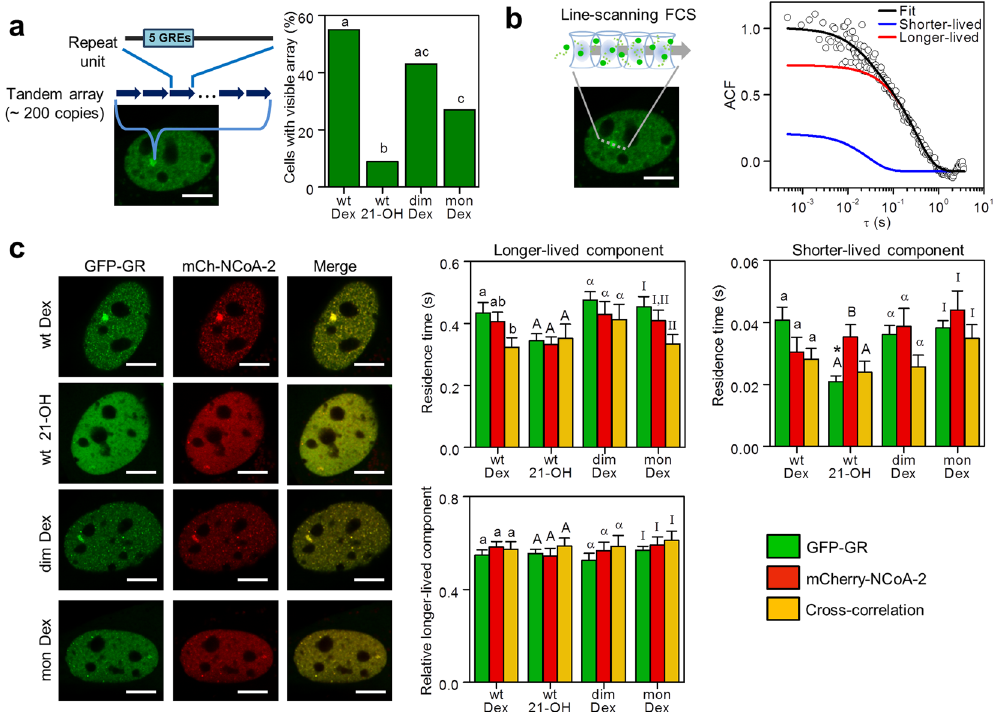
Figure 3. GR and NCoA-2 interactions with GREs depend on the receptor conformation. ( a ) Representative image of a 3617 cell expressing GFP-GR. The MMTV-array is visualized as a bright spot in the nucleus (Scale bar: 5 µ m). The ability of GR recruitment to the MMTV-array was analyzed in cells expressing the receptor fused to GFP (wild type, GRdim or GRmon) and treated with Dex or 21-OH as the percentage of cells showing a visible array (69 < n < 79). Bars with the same superscript letters represent data not significantly different from each other (p < 0.05) according to Marascuilo’s multiple comparisons procedure (see Methods). ( b ) Line- scanning FCS experiments were run in cells expressing GFP-GR; the laser was set to scan along a line across the MMTV-array which position was then determined with subpixel precision to obtain the intensity time-trace. Representative ACF data fitted with a model that considers binding to fixed targets in two different time-scales (equation (3), continuous line). ( c ) Similar line-FCS experiments run in cells expressing mCherry-NCoA-2 and GFP-GR (wild type, GRdim or GRmon), and treated with Dex, 21-OH or vehicle (Veh) (22 < n < 26) (Scale bar: 5 µ m) provided the mean residence times at shorter-lived and longer-lived targets and the relative proportion of molecules bound to longer-lived sites with respect to those engaged in interactions. Bars with the same superscript letters and text font represent data not significantly different from each other (p < 0.05). Bars marked with asterisk ( * ) represent data significantly different from those obtained in the control condition (GFP-GR + mCherry-NCoA-2 + Dex) (p <